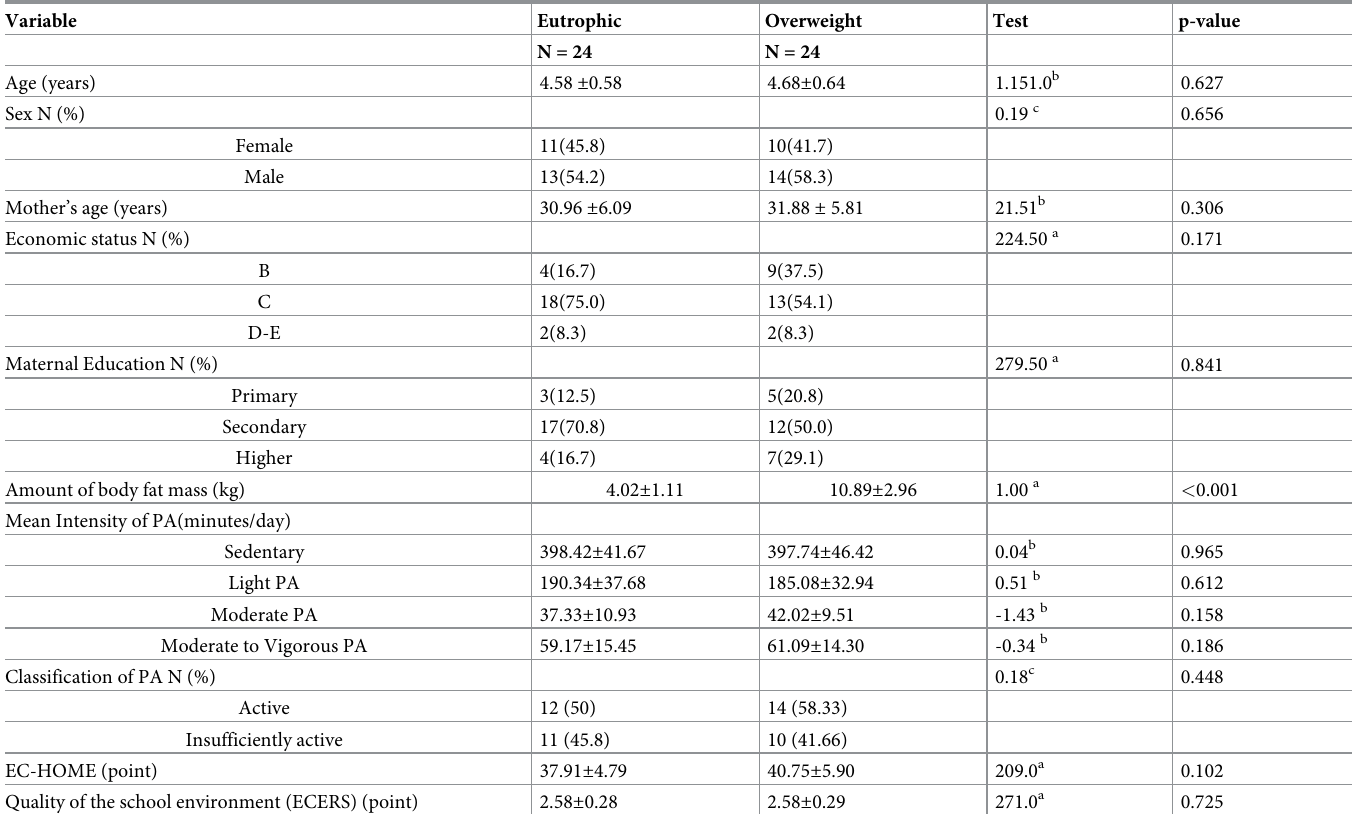
Table 1. Sample characteristics.